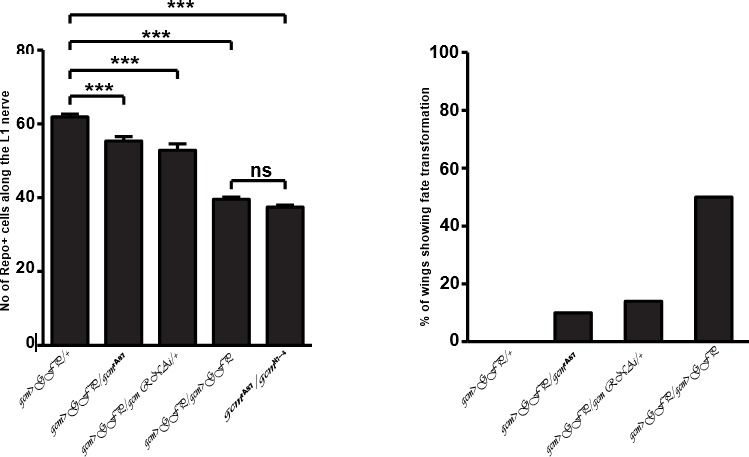
DOI:
http://dx.doi.org/10.7554/eLife.15983.028